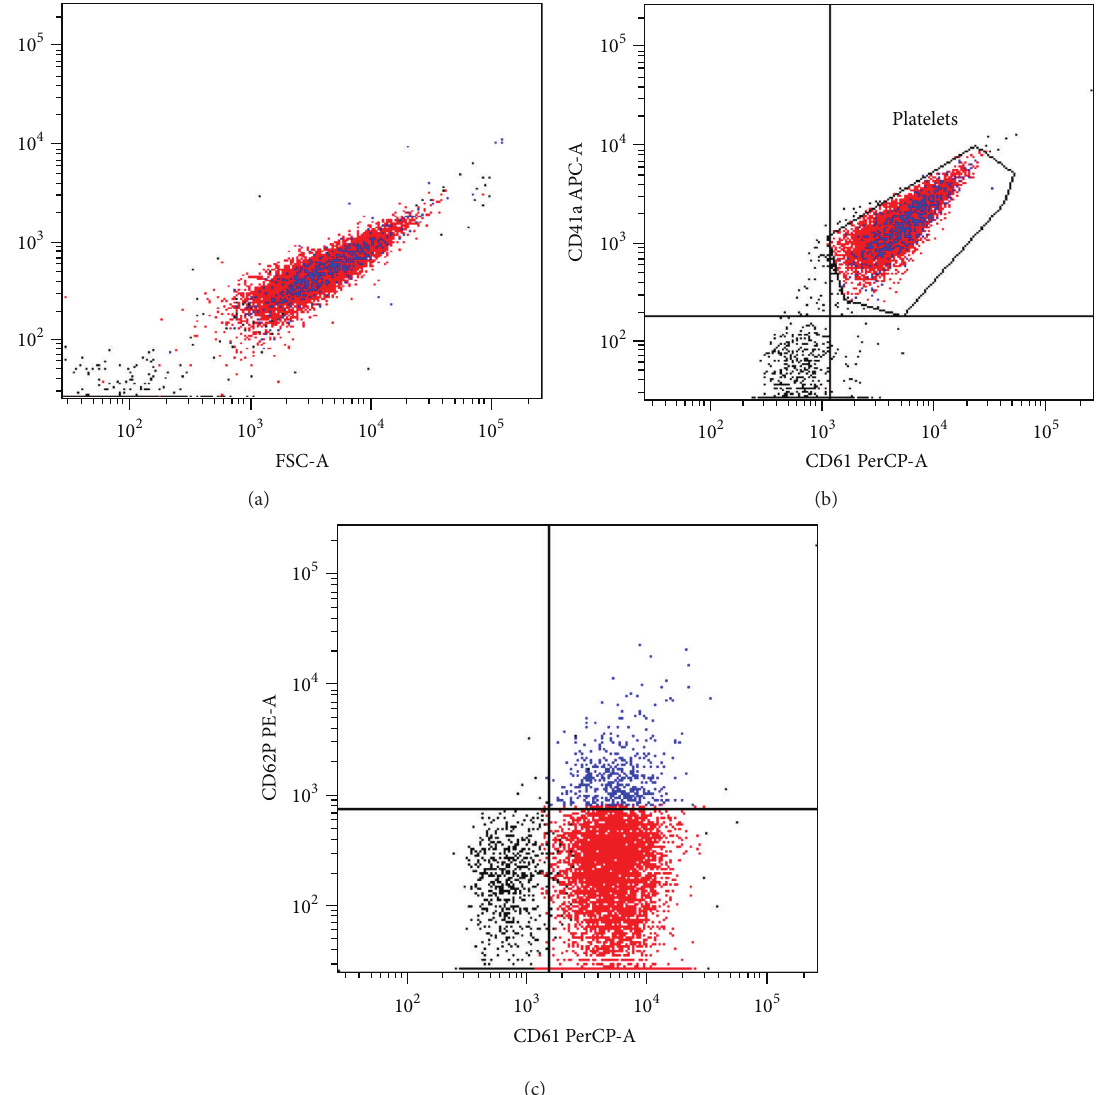
Figure 2: PRC sample is gated based on size (forward scatter) and granularity (side scatter) (a). CD61 + versus CD41 + includes only the population of platelets positive to both the markers (b). CD61 + versus CD62 + shows the platelets in the nonactivated PRC positive to CD61 + and about 5.2% positive to CD62 +